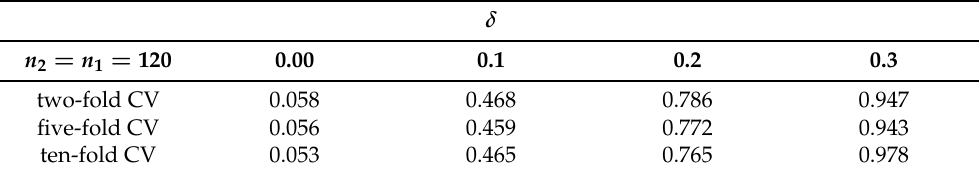
Table 6. Size and power of NT 2 A in Setting 5 (difference averaged in total vector µ 2 = µ 1 + δ 1 40 ).